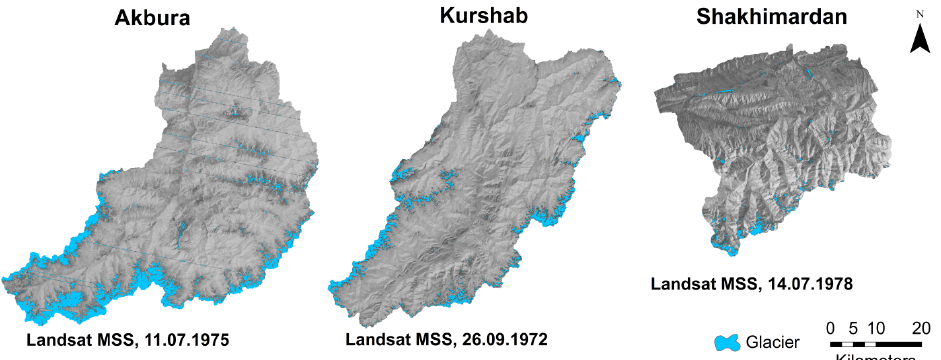
Figure 5. The Landsat MSS (Multispectral Scanner System) satellite images (79 m) with delineated glacial and snowfield